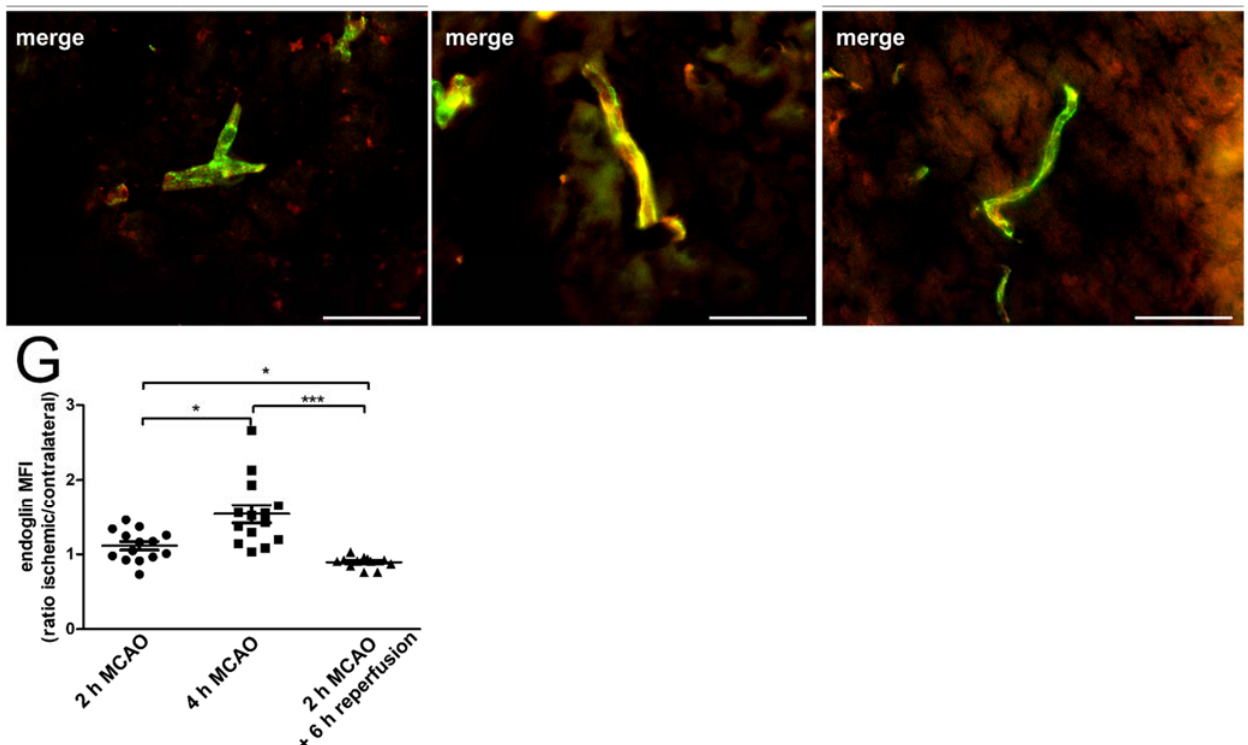
Figure 3. The upregulation and release of ENG in permanent versus transient middle cerebral artery occlusion (MCAO) in a murine stroke model. Representative immunohistochemistry of cerebral ENG after 2 h ( A ) and 4 h ( B ) of permanent MCAO or after 2 h of MCAO with an additional 6 h of reperfusion ( C ). Sections show tissue 0.5 mm anterior from bregma. Quantification of ENG expression in the basal ganglia depicted as the ratio of the mean fluorescence intensity between three corresponding regions of interest in ischemic vs. contralateral hemispheres, using ImageJ in n = 4 (2 h MCAO + 6 h reperfusion) and n = 5 (2 + 4 h MCAO) animals. (* p < 0.05; ** p < 0.01). A – C: scale bar = 1000 μ m. ( D–F ) Endothelial expression of ENG (red) on an individual vessel as identified by CD31 staining (green) of the basal ganglia region of the ischemic hemisphere in more detail. Scale bar = 50 μ m.